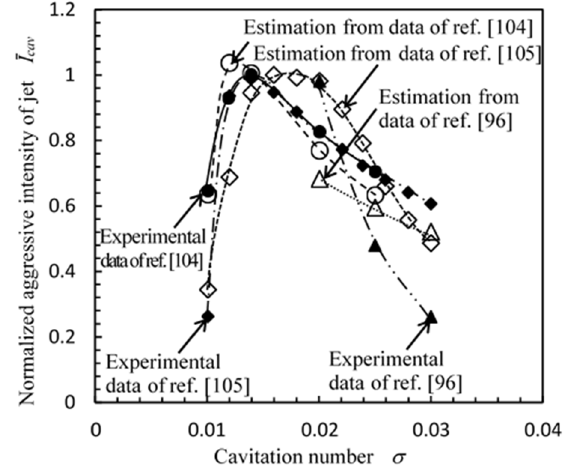
Figure 17. Normalized aggressive intensity of a cavitating jet as a function of cavitation number [3].